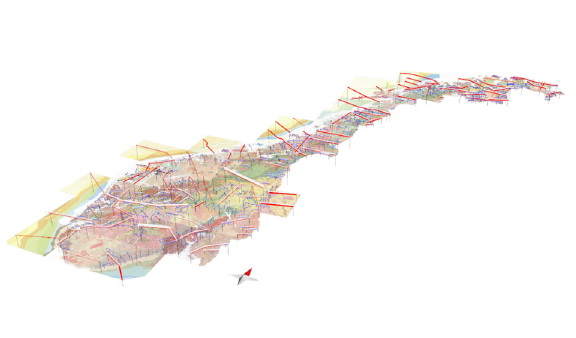
Figure 1: Geological profile coverage in the whole of Norway. In blue are the traces of the 110 250K profiles. In green are the traces of the 54 950K profiles.